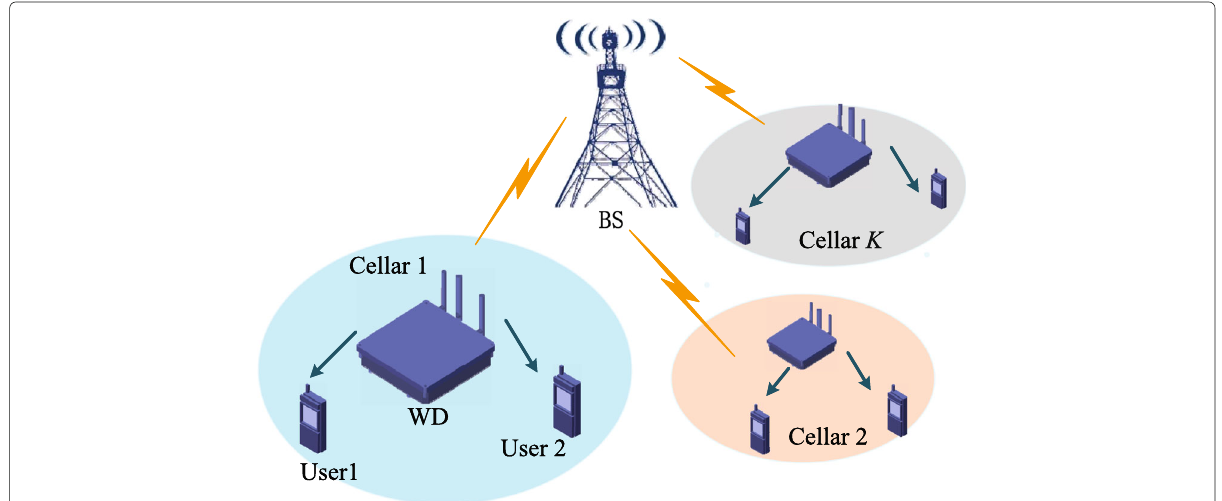
Fig. 1 System model. A D2D communication networks including one BS and K underlaying systems, in which a WD can transmit information to two users under NOMA